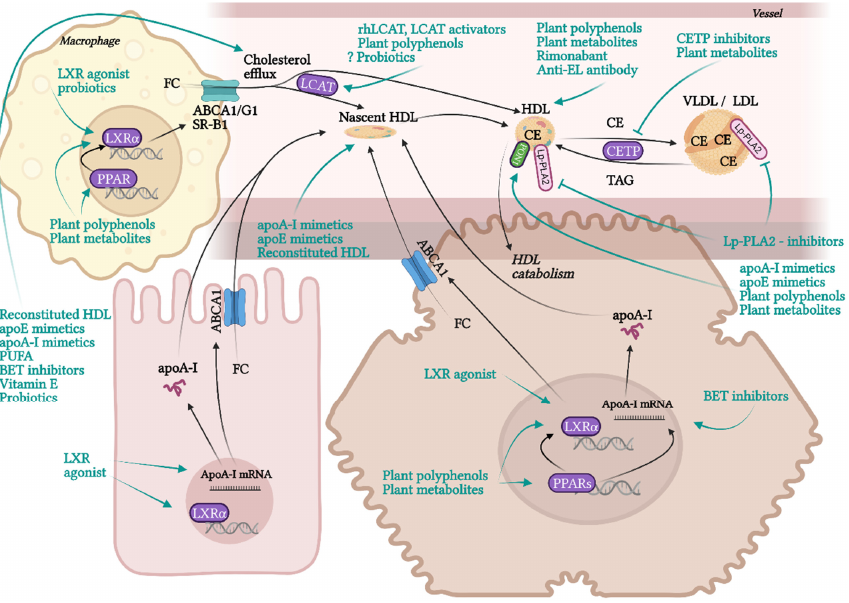
Figure 2. Simplified schematic representation of HDL-targeted therapies: Drugs in clinical trials. Apolipoprotein A-I (apoA-I); ATP-binding Cassette Receptor A1 (ABCA1); ATP-binding cassette receptor A1/G1 (ABCA1/G1); Cholesterol ester (CE); Cholesteryl ester transfer protein (CETP); Free Cholesterol (FC); Hepatic scavenger receptor B1 (SR-B1); Lecithin-Cholesterol Acyltransferase (LCAT); Lipoprotein-associated phospholipase A2 (Lp-PLA2); Liver X Receptor α (LXR α ); Paraoxonase 1 (PON1); Peroxisome Proliferator-Activated Receptor (PPAR); Triacylglycerols (TAG). Created with BioRender.com (accessed on 15 September 2022). Table 4. HDL-affecting drugs for cardiovascular applications tested in clinical trials .